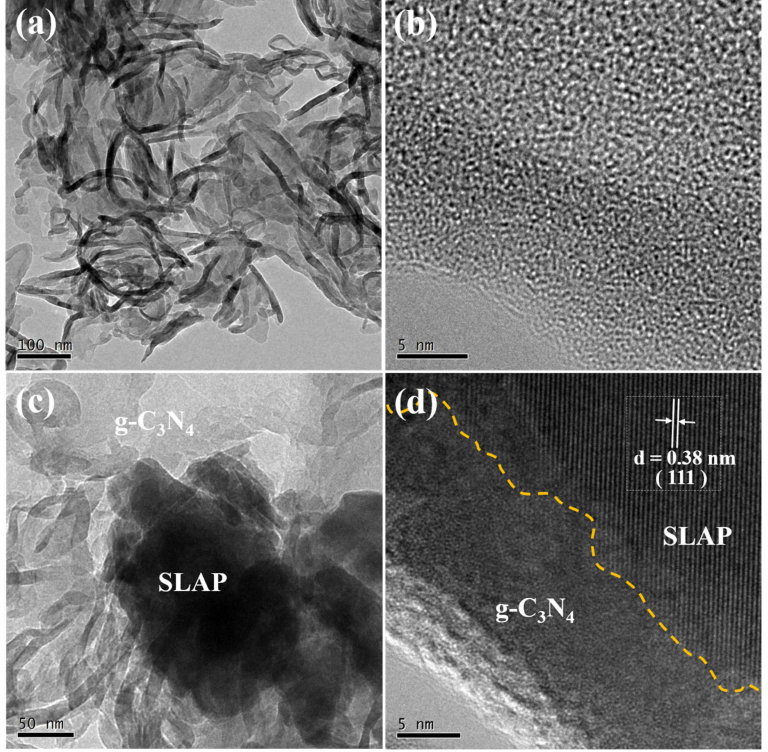
Figure 4. ( a ) TEM image of g-C 3 N 4 ; ( b ) high-resolution TEM image of g-C 3 N 4 ; ( c ) TEM image of SLAP@CN-6; ( d ) high-resolution TEM image of